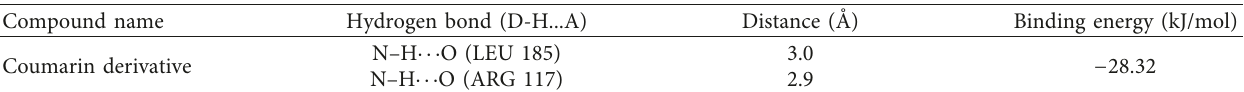
Figure 5: (a) FTIR spectra analysis of HSA (1 µ M) and HSA-coumarin derivative complex (0–0.8 µ M). (b) CD spectral analysis of HSA (1 µ M) and HSA-coumarin derivative complex (0–1.4 µ M). Table 3: Binding energy and hydrogen bonding interaction of the coumarin derivative with HSA active site